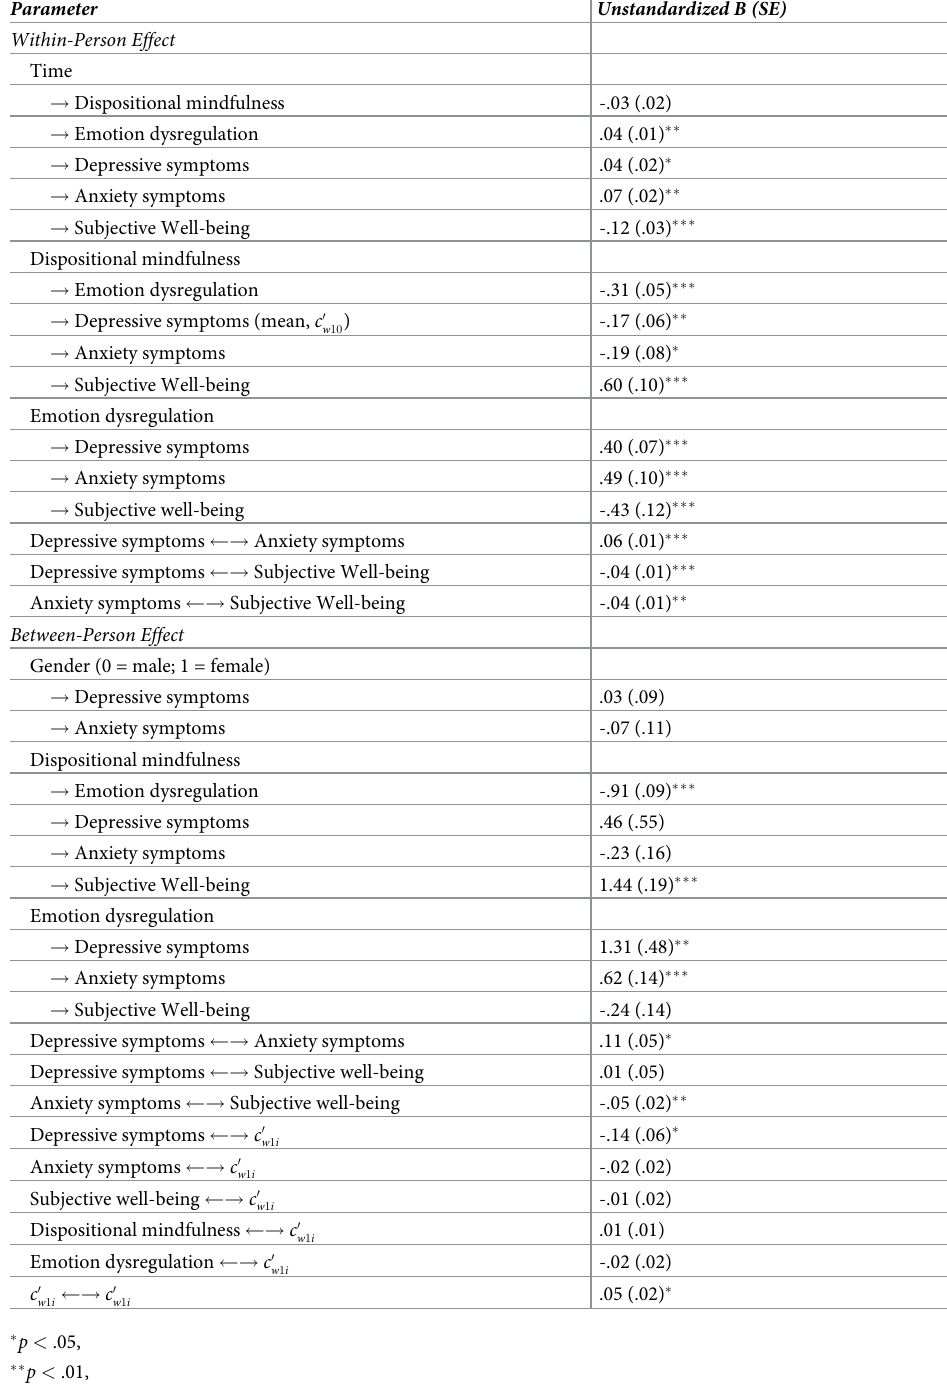
Table 3. Unstandardized parameter estimates and standard errors of the multilevel